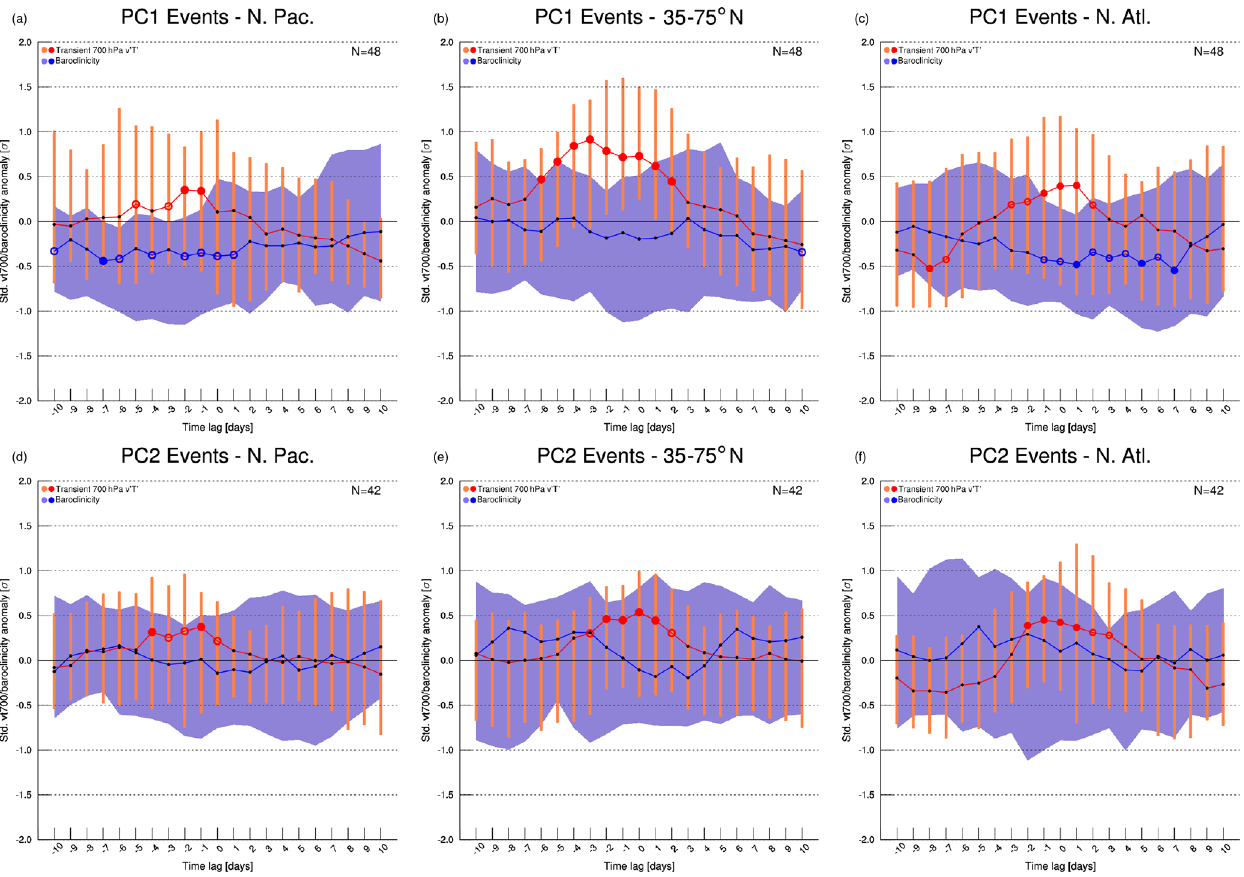
Figure 8. Medians of standardized anomalies of 7d mean, area-averaged baroclinicity s (blue line) and meridional heat flux v ∗ T ∗ (red line) for the considered set of (a–c) CRWP1 and (d–f) CRWP2 events, at different lead times with respect to t max , for (a, d) the North Pacific storm track (30–50 ◦ N, 130–180 ◦ E), (b, e) the whole mid-to-high latitudes (35–75 ◦ N) and (c, f) the North Atlantic storm track (30–50 ◦ N, 80–30 ◦ W) regions. The length of the orange bars indicates the interquartile range of the heat flux distribution, as well as the width of the blue shading for s . Empty (filled) dots indicate anomalies exceeding the 95th (99th) percentile of the respective bootstrapped